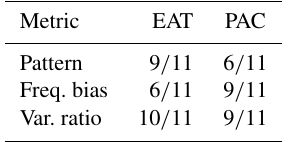
Table 2. Number of models developed by the same institution that improve on CMIP5 to CMIP6 for three metrics: average pattern cor- relation, average frequency bias and variance ratio. There is a total of 11 institutions for which at least one model is available for both CMIP phases. If more model versions are available for a single in- stitution, the average metric among all models is